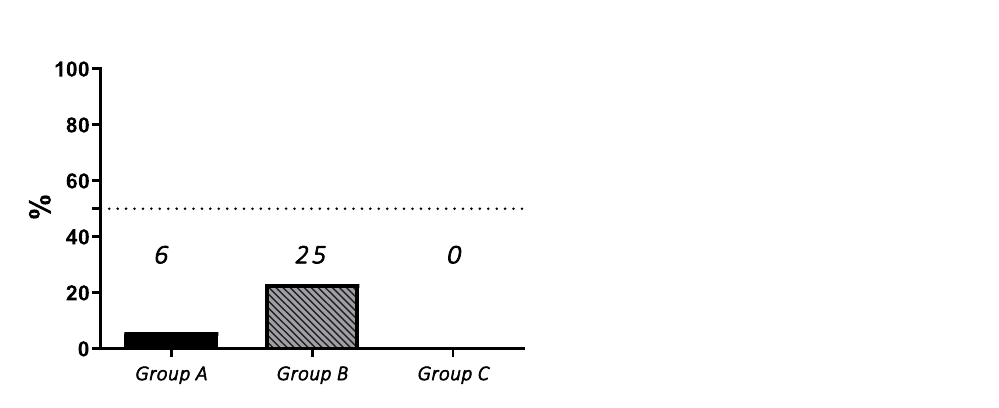
Figure 3. Percentage of patients who failed to achieve mid-parental height (MPH) target in the three groups.